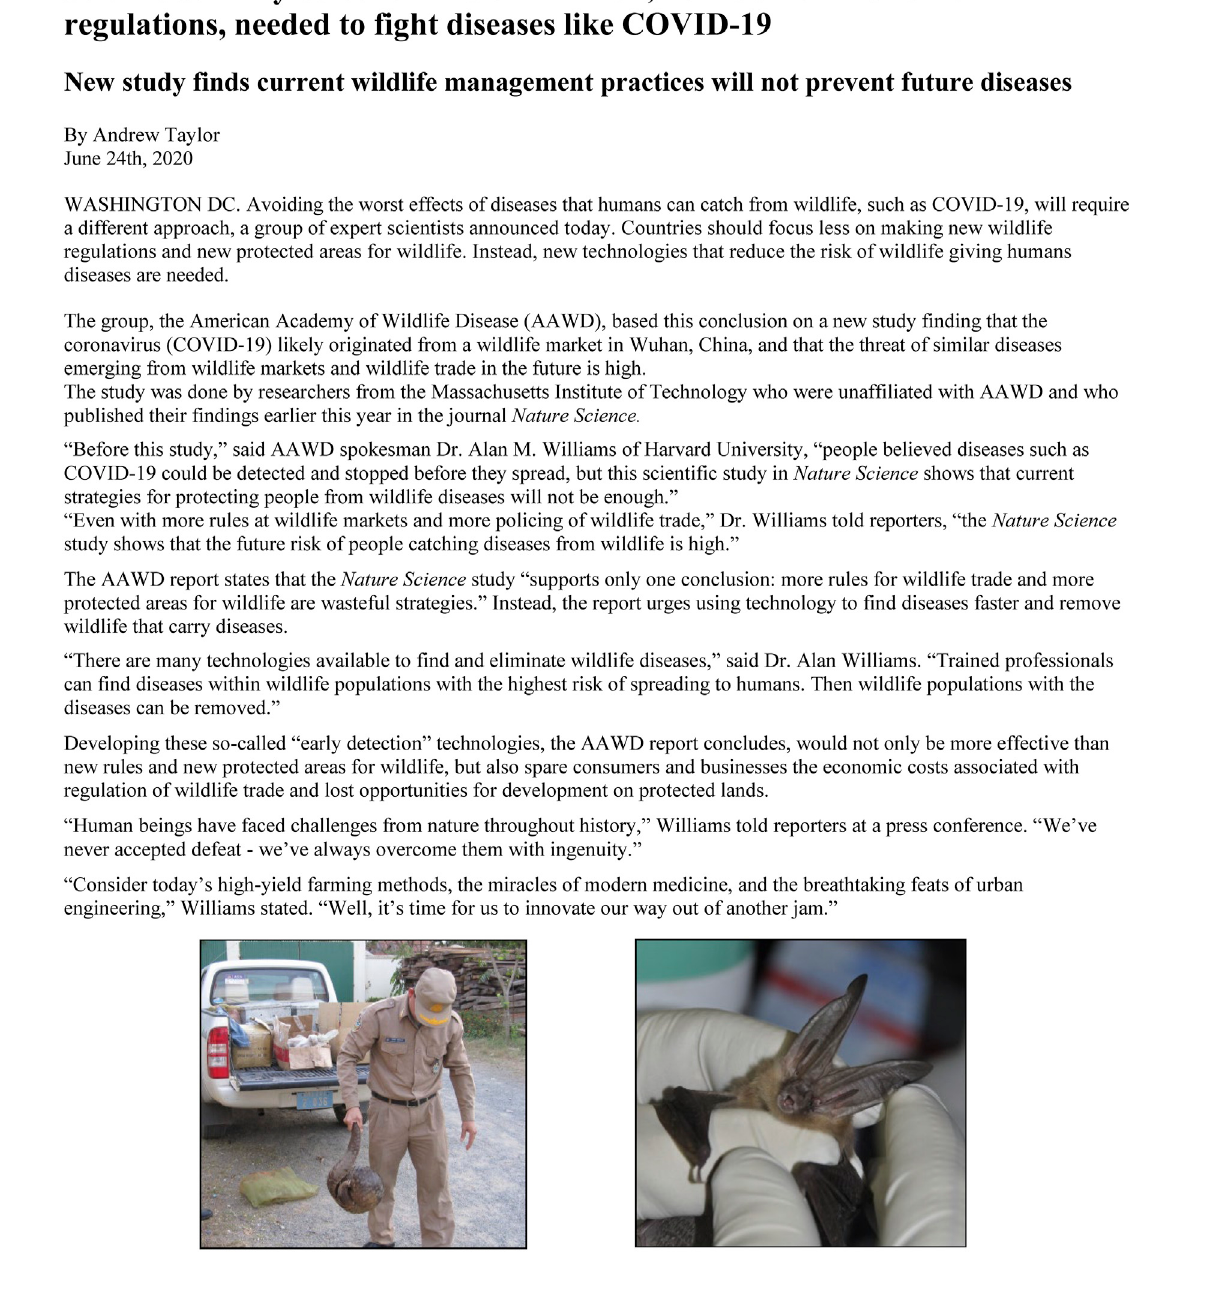
FIGURE 1 | Technocratic framing of COVID-19 science highlighting human ingenuity and technology as means to prevent and control the emergence and spread of zoonoses. Modeled after Kahan et al. (2015), information from Bosch et al. (2015) and Grant et al. (2017). Images obtained from Creative Commons. Left image: “ PangolinRescue ” byWildlifeAllianceislicensedunderCCBY-SA2.0.Rightimage: “ Townsend ’ sbig-earedbat ” byUSFWSHeadquartersislicensedunderCCBY2.0.